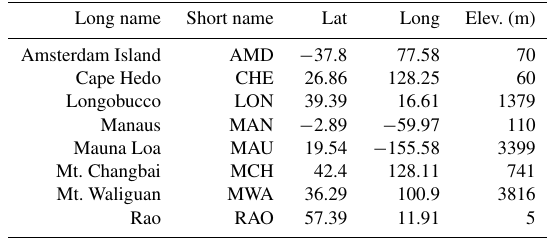
Table 2. Characteristics of ground-based sites measuring Hg P